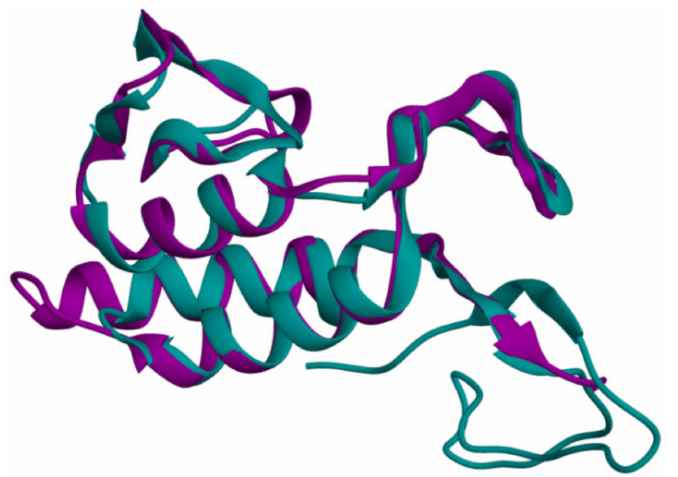
Figure 6. Superimposition of the 3D structure of leptulipin (magenta) with the honey bee PLA2 (cyan), showing that both toxins significantly